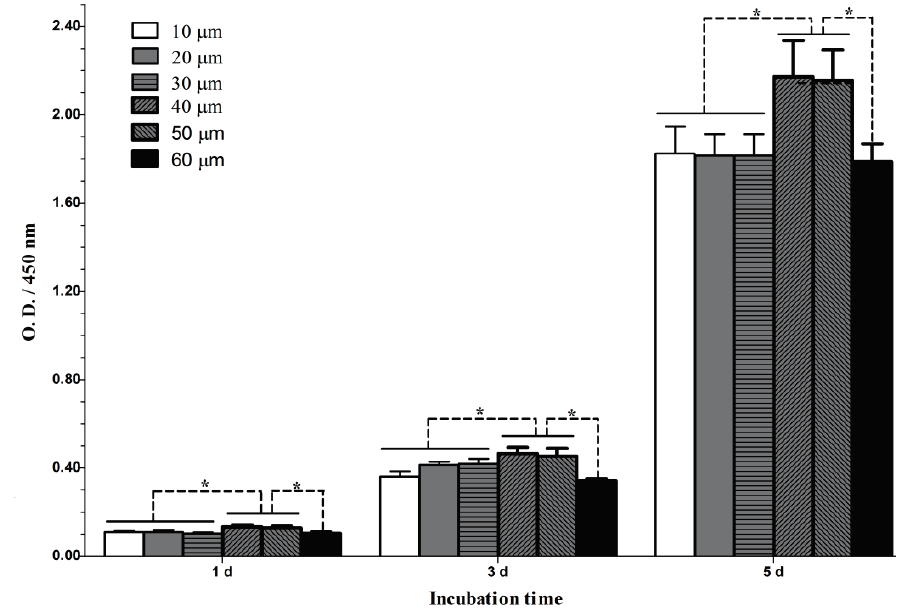
Figure 3. Cell proliferation on microporous structures with different micropore diameters. n = 6, * p <